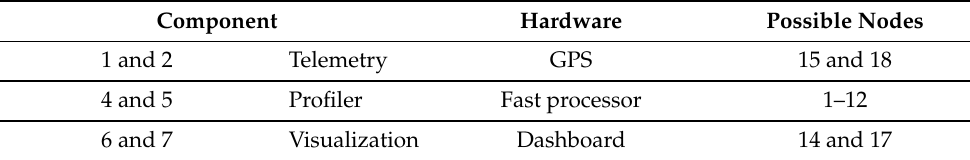
Table 6. Speed profiling application